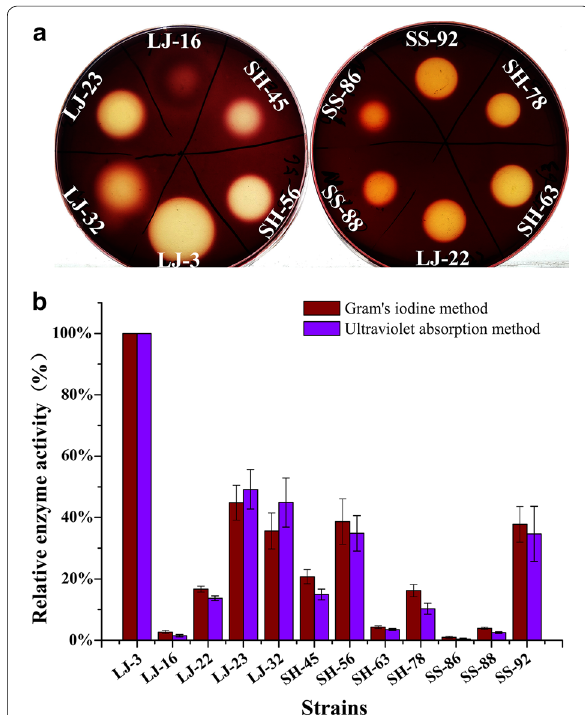
Fig. 3 Quantification of alginate lyase activity. a Gram’s iodine method showing the clearance zone of twelve strains; b quanti- fication of alginate lyase activities by Gram’s iodine method and ultraviolet absorption method. The enzyme activities of LJ-3 strain detected by both methods were taken as 100%, respectively. Each value represents the mean of three replicates standard ±